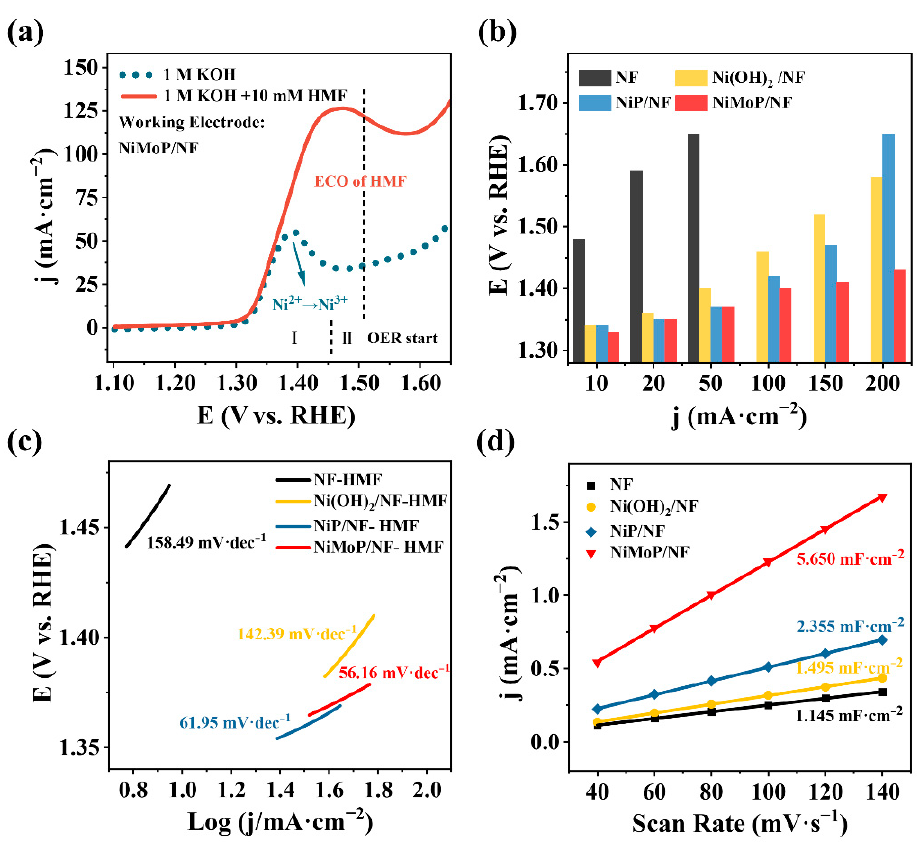
Figure 4. ( a ) LSV curves of NiMoP/NF in 1.0 M KOH with and without 10 mM HMF at a 10 mV · s − 1 scan rate; the corresponding ( b ) anode potential summarization; ( c ) Tafel plots; ( d ) Cdl for NF, Ni(OH) 2 /NF, NiP/NF, and NiMoP/NF in 1.0 M KOH with 50 mM HMF.